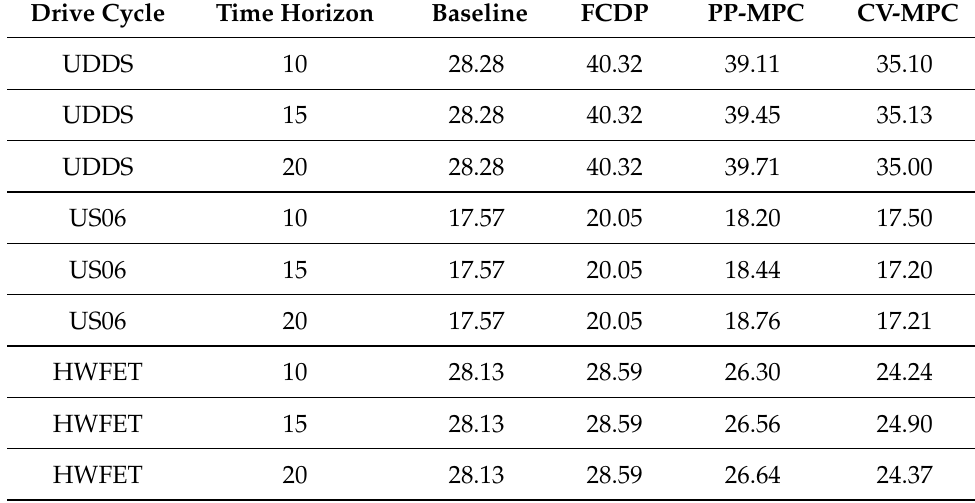
Table 8. Fuel economy km/L for 2010 Toyota Prius model with DP-derived methods and Autonomie baseline on EPA dynamometer drive cycles (time horizon only effects the PP-MPC and CV-MPC